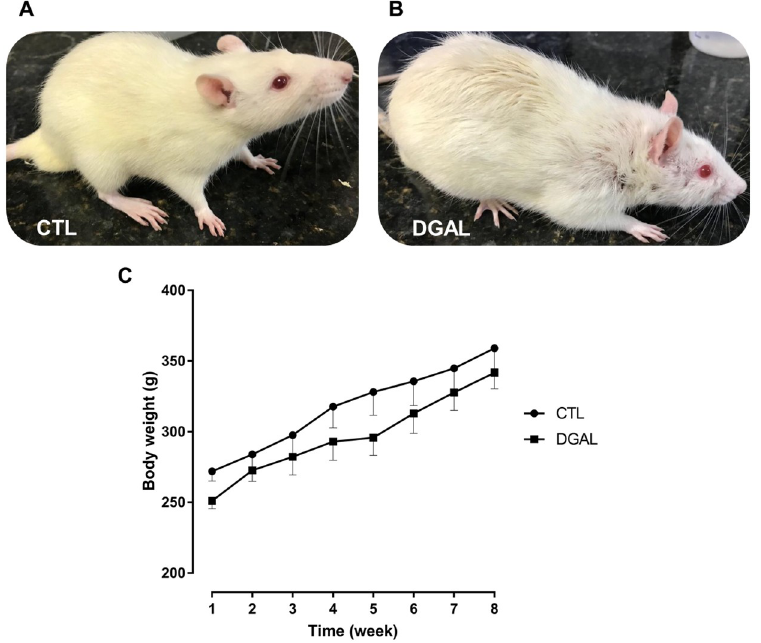
Fig 1. Physical appearance at eight-weeks of treatment for (A) CTL, and (B) DGAL animals, (C) Average body weight (g) in function of time (8 weeks total) CTL ( ● ) and DGAL ( & ). The data are expressed as mean ± SEM (n = 5). The data were analyzed using the two-way ANOVA statistical test, followed by the Bonferroni post-test. Groups: CTL = vehicle; DGAL = D-(+)-galactose 150 mg/Kg.